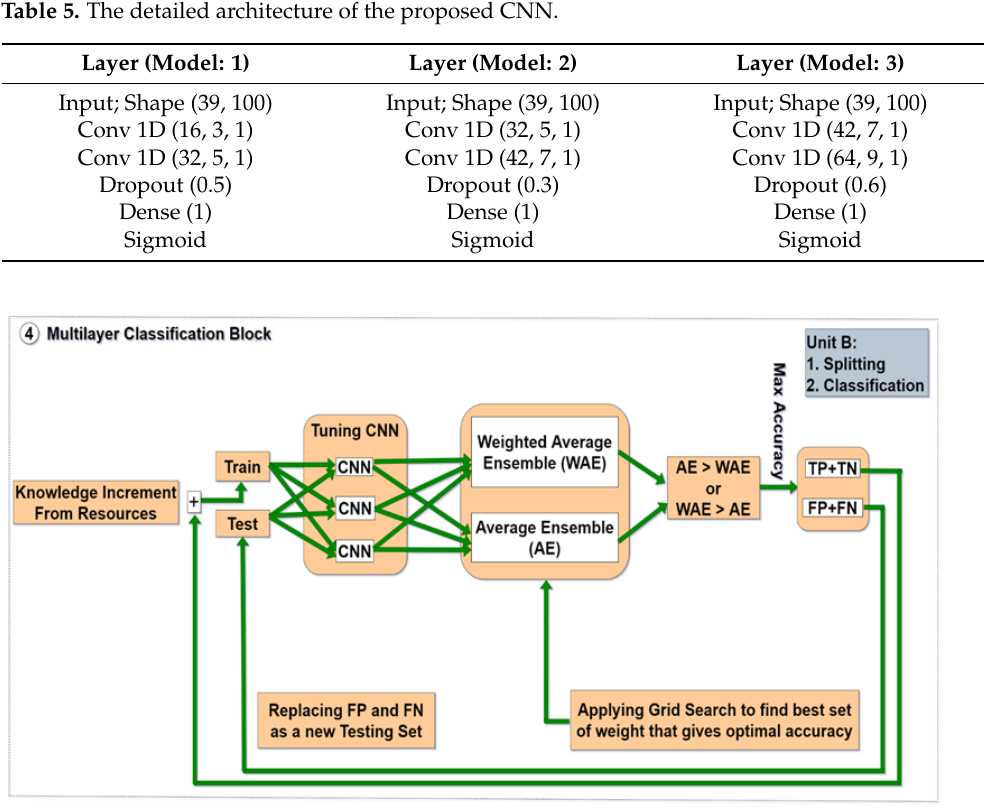
Table 4. Hyper-parameters tuning demonstration. Table 5. The detailed architecture of the proposed CNN.